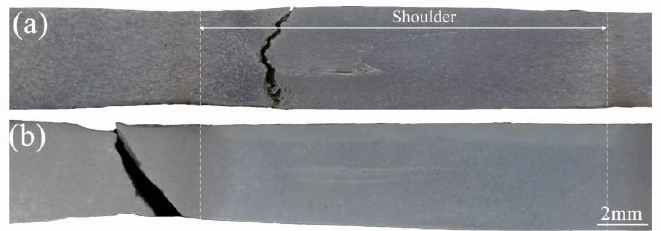
Figure 12. Typical fracture location of joints at different rotation speeds: ( a ) 600 r/min; ( b ) 800 r/min.